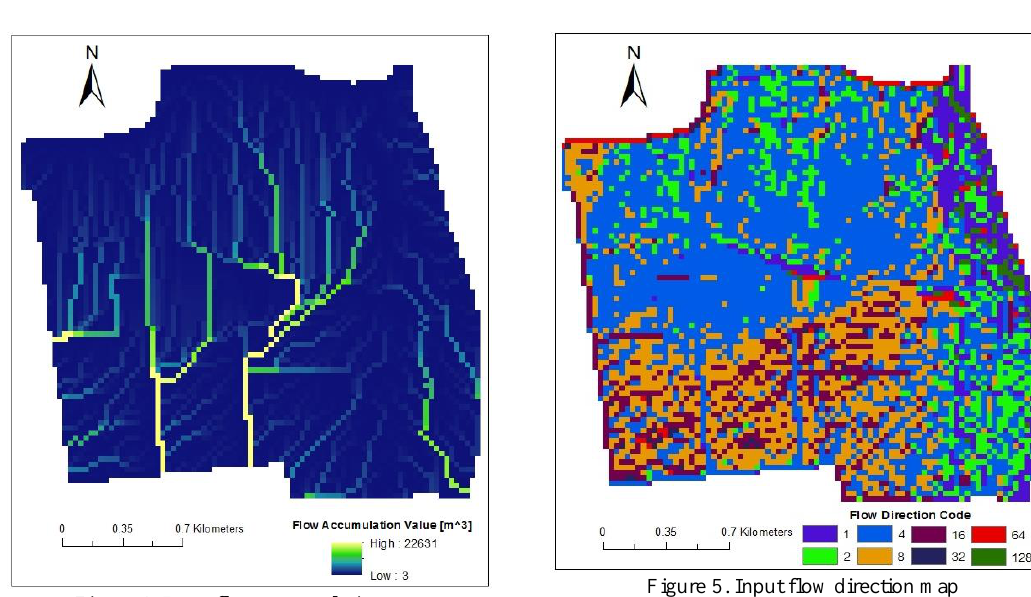
Figure 4. Input flow accumulation map